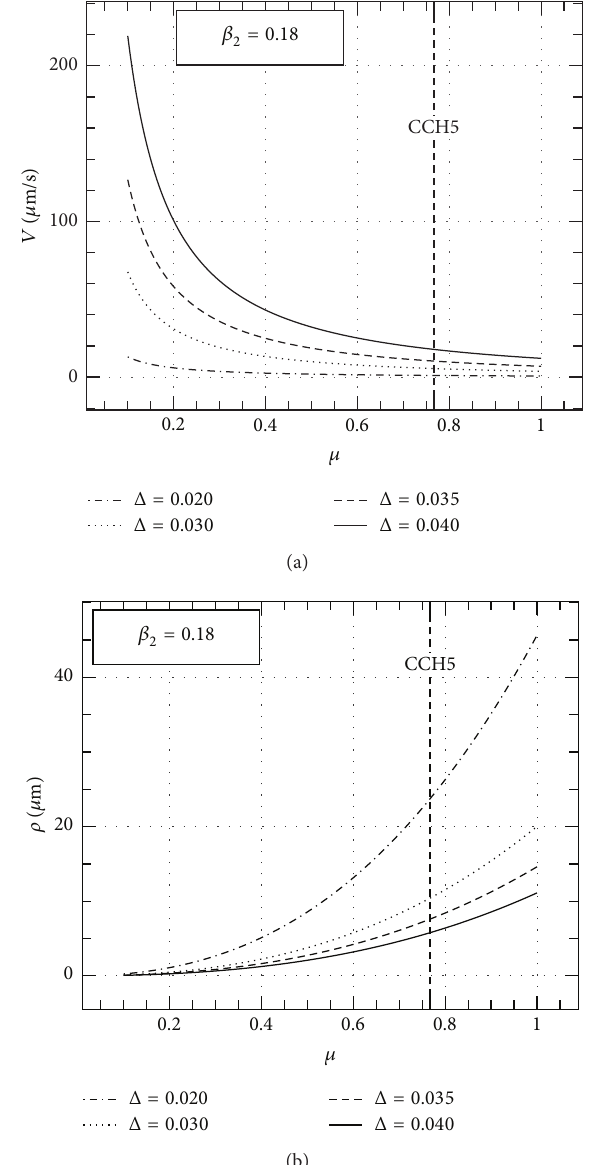
Figure3: Observablequantities; (a)growthvelocity 𝑉 from(21)and (b) tip curvature radius 𝜌 from (22) with the thermal diffusion anisotropy strength 𝜇 at different values of the dimensionless undercooling Δ .